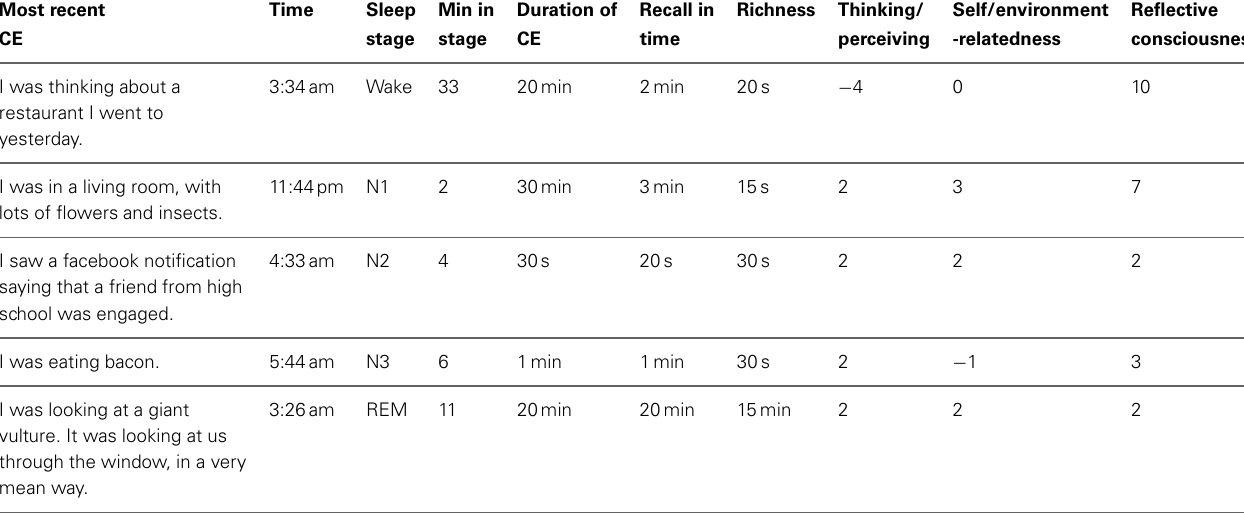
Table 3 | Illustrative examples of most recent conscious experiences and their characteristics. Most